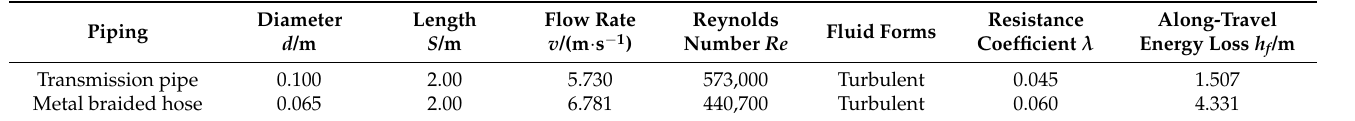
Table 1. Calculation table of unit energy losses along the